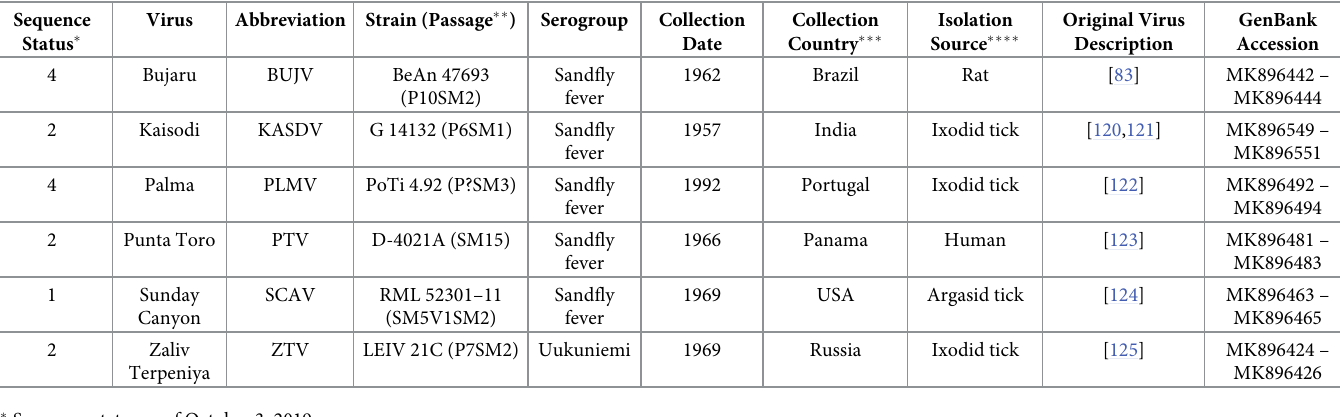
Table 2. Sequenced genomes of 6 viruses belonging to Phenuiviridae (Phlebovirus and Uukuvirus)